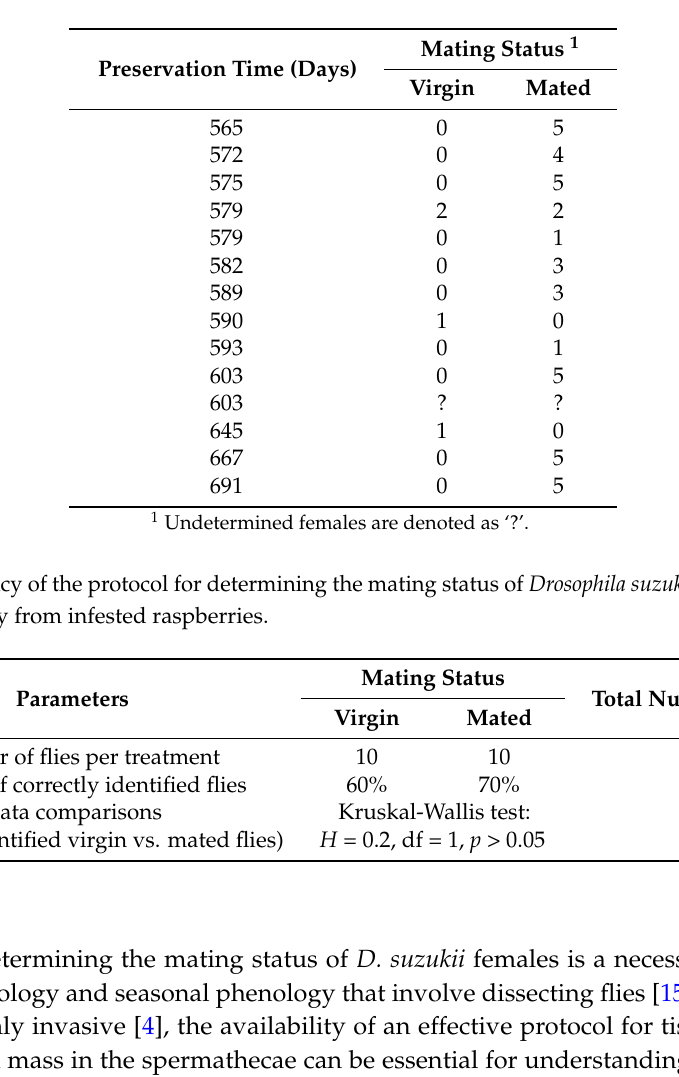
Table 1. Efficiency of the protocol for determining mating status in different Drosophila suzukii individuals collected across different locations in Wisconsin in 2014. Mating Status 1 Preservation Time (Days)